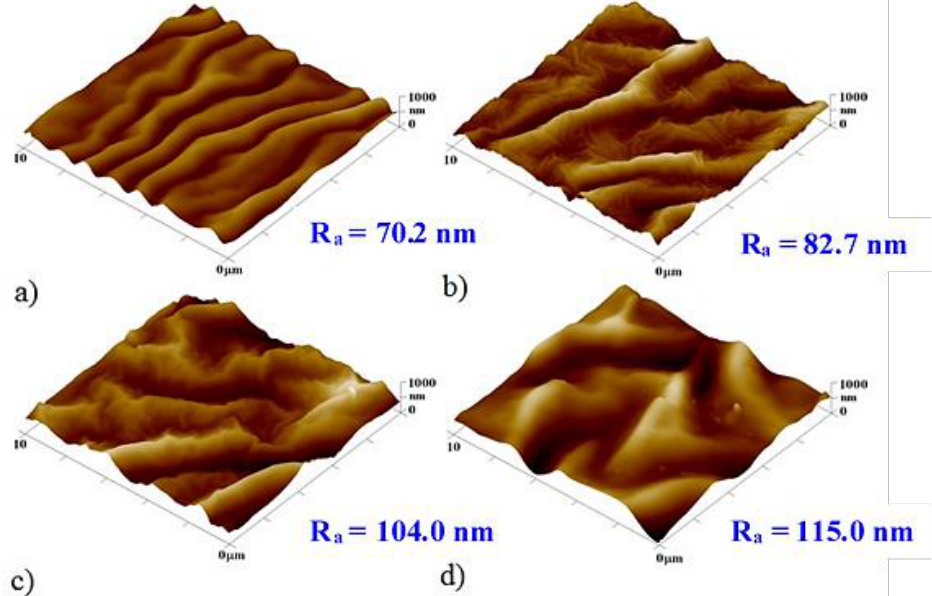
Figure 5. AFM images of the heated PLLA samples with a sputtered titanium bottom layer and a gold top layer. ( a ) Ti and Au layers of 2 and 48 nm, respectively; ( b ) Ti and Au layers of 5 and 45 nm, respectively; ( c ) Ti and Au layers of 10 and 40 nm, respectively; ( d ) Ti and Au layers of 25 and 25 nm, respectively. R a is the mean surface roughness in nanometers.